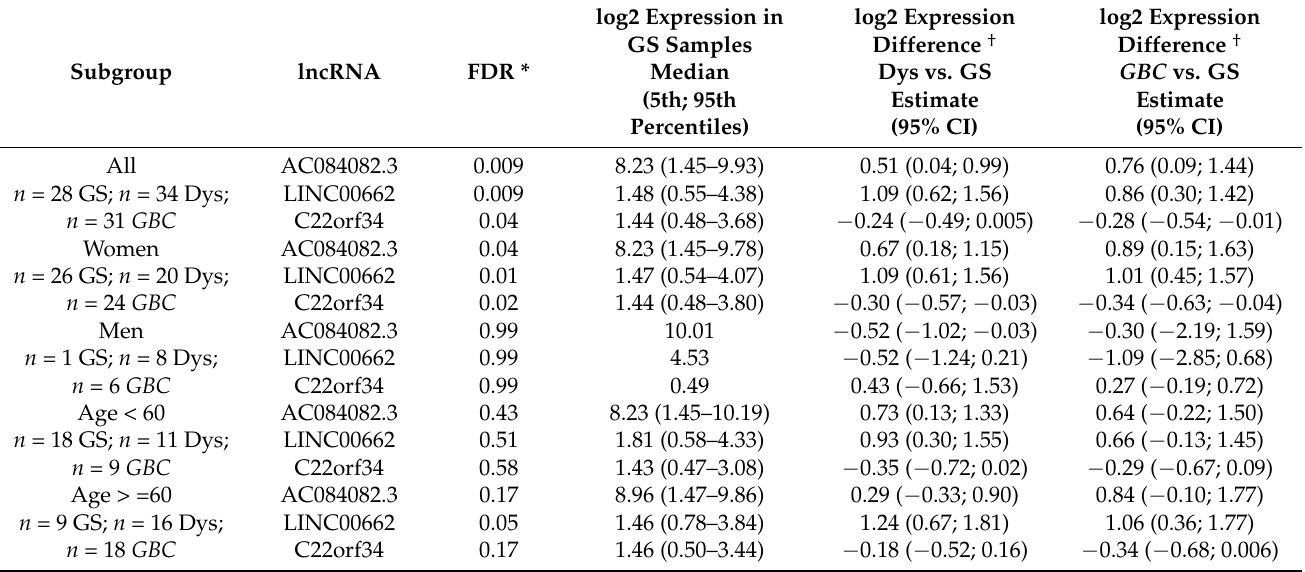
Table 1. FFPE tissue expression of the three preselected lncRNAs in the complete dataset and stratified results by gender and